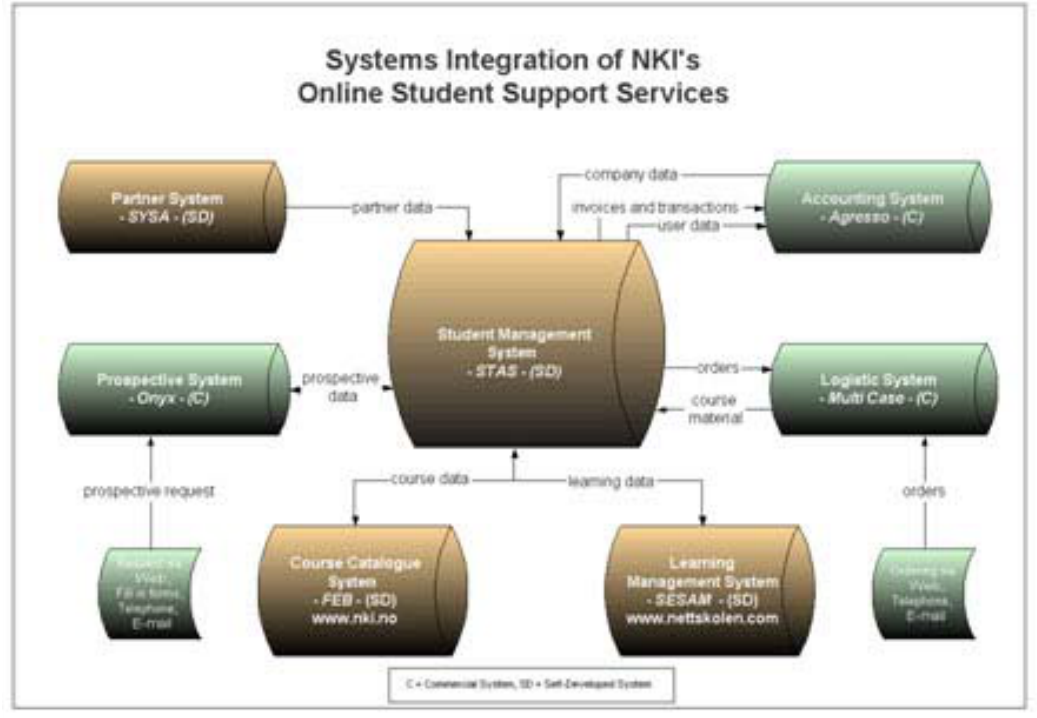
Figure 1. NKI’s integrated systems for online administration and student